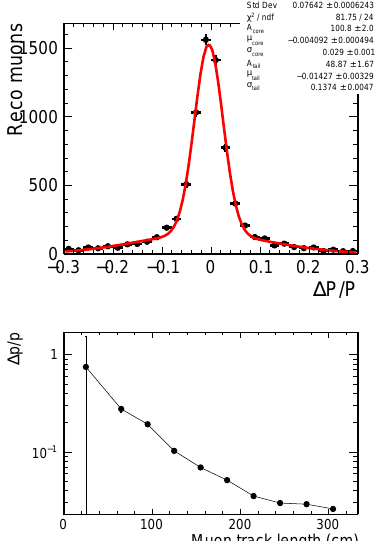
Figure 64. ( Top ): the momentum resolution for reconstructed muons in GArSoft, in a sample of ν µ CC events. The events were generated using the LBNF flux. The Gaussian fit to the central core of the ∆ p / p distribution, containing 2/3 of events, has a width of 2.7%. The tails are well described by a 12% resolution. ( Bottom ): The momentum resolution as a function of track